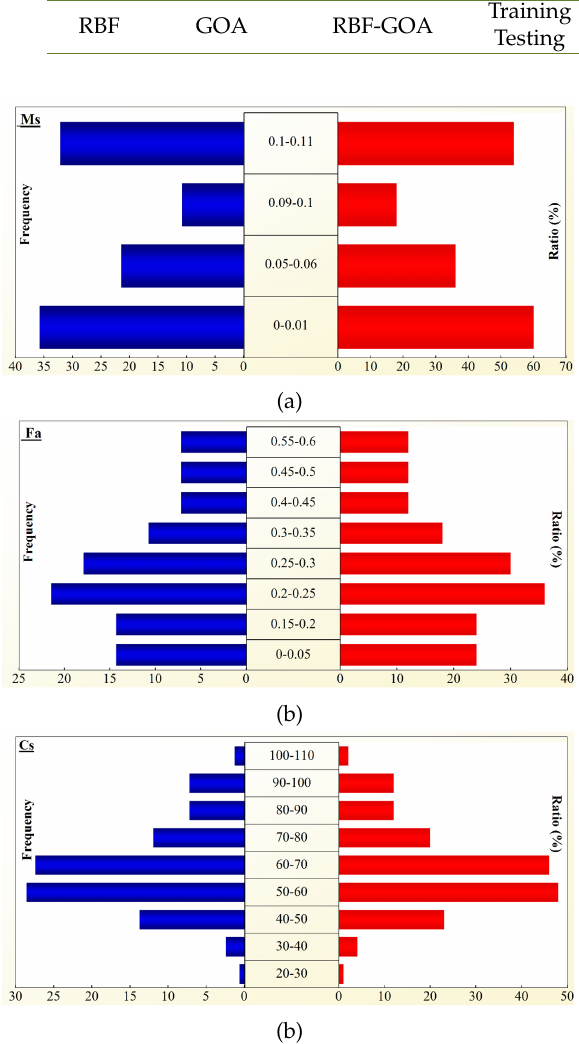
of training and testing. Sample ratings range from 0 to 170, and compressive strength ranges from 20 to 120 based on MPa. The black circular dots represent measurements of any shape. The ideal method is to place the test and training points directly above the measurement points. According Fig. 4. The main components of dataset frequencies and to the above description, most samples are dispersed in the participation ratio tensile section because 30% belong to the test section, and 70% belong to the tensile section. The figure shows that the RBF-MPA model is the ideal case involved. That is all for the number of train and test points in the black dots. In this figure, the RBF-MPA model has improved performance and outperformed the RBF-GOA model. The error rate is displayed as a boxplot, as shown in Fig. 9. Fig. 9(a), part of the RBF-GOA model, has the highest error rates in the train and test sections. The maximum error is 10, in Fig. 9(a), which is 11.31 in the test section and 14.39 in the train section, indicating a high error in the